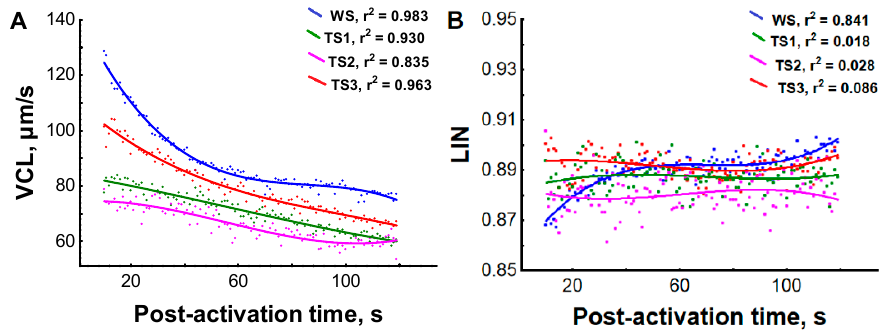
Figure 3. Sperm motility parameters of Wolffian duct sperm and in vitro matured testicular sperm from experimental groups of sterlet at different post-activation times. ( A ) Curvilinear velocity (VCL, µ m/s), ( B ) linearity (LIN). TS1—testicular sperm from fish of group OW, held in fish-farming ponds (water temperature 2 ◦ C); TS2—testicular sperm from fish of group ST, adapted to spawning temperature of 14 ◦ C, spermiation was not induced; TS3—testicular sperm from fish of group ST-HI, adapted to spawning temperature of 14 ◦ C, spermiation was induced; WS—sperm collected from Wolffian duct (naturally matured) from fish of group ST-HI. Each dot represents an average value for each combination of male/experimental group/post-activation time. Lines of polynomial regression of third-order and corresponding r 2 are presented. Different colors of dots and lines correspond to the used sperm sample: blue—from WS, green—from TS1, purple—from TS2, red—from